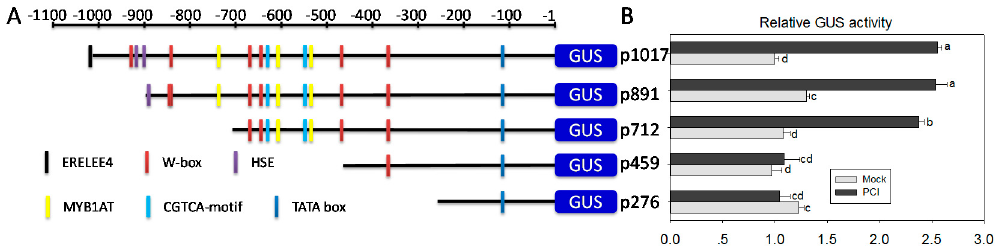
Figure 6. Deletions analysis of ChiIV3 promoter in response to P. capsici inoculation. ( A ) Schematic diagram of the reporter vector constructs with serial 5’-deletions of ChiIV3 promoter fused to the GUS reporter gene. The serial 5 ′ deletions of ChiIV3 promoter were fused to the GUS reporter gene in the vector pMDC163 and transformed into GV3101 for tobacco transformation. Seedlings of T3 lines were used for GUS activity assay. Putative cis -elements in ChiIV3 promoter were represented by boxes with different colors; ( B ) The expression of GUS driven by the five deletions in plants of T3 tobacco lines in response to P. capsici inoculation. The activity of GUS driven by p1017 with mock treatment was set to “1”. Values are means ± SD ( n = 6). Different letters indicate significant differences determined by Fisher’s protected LSD test ( p < 0.05).